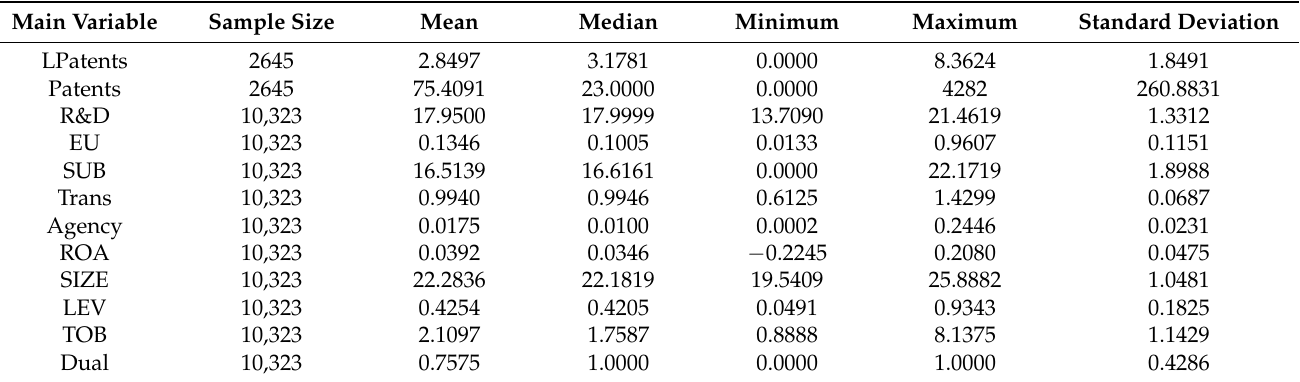
Table 1. Descriptive statistics of each variable.